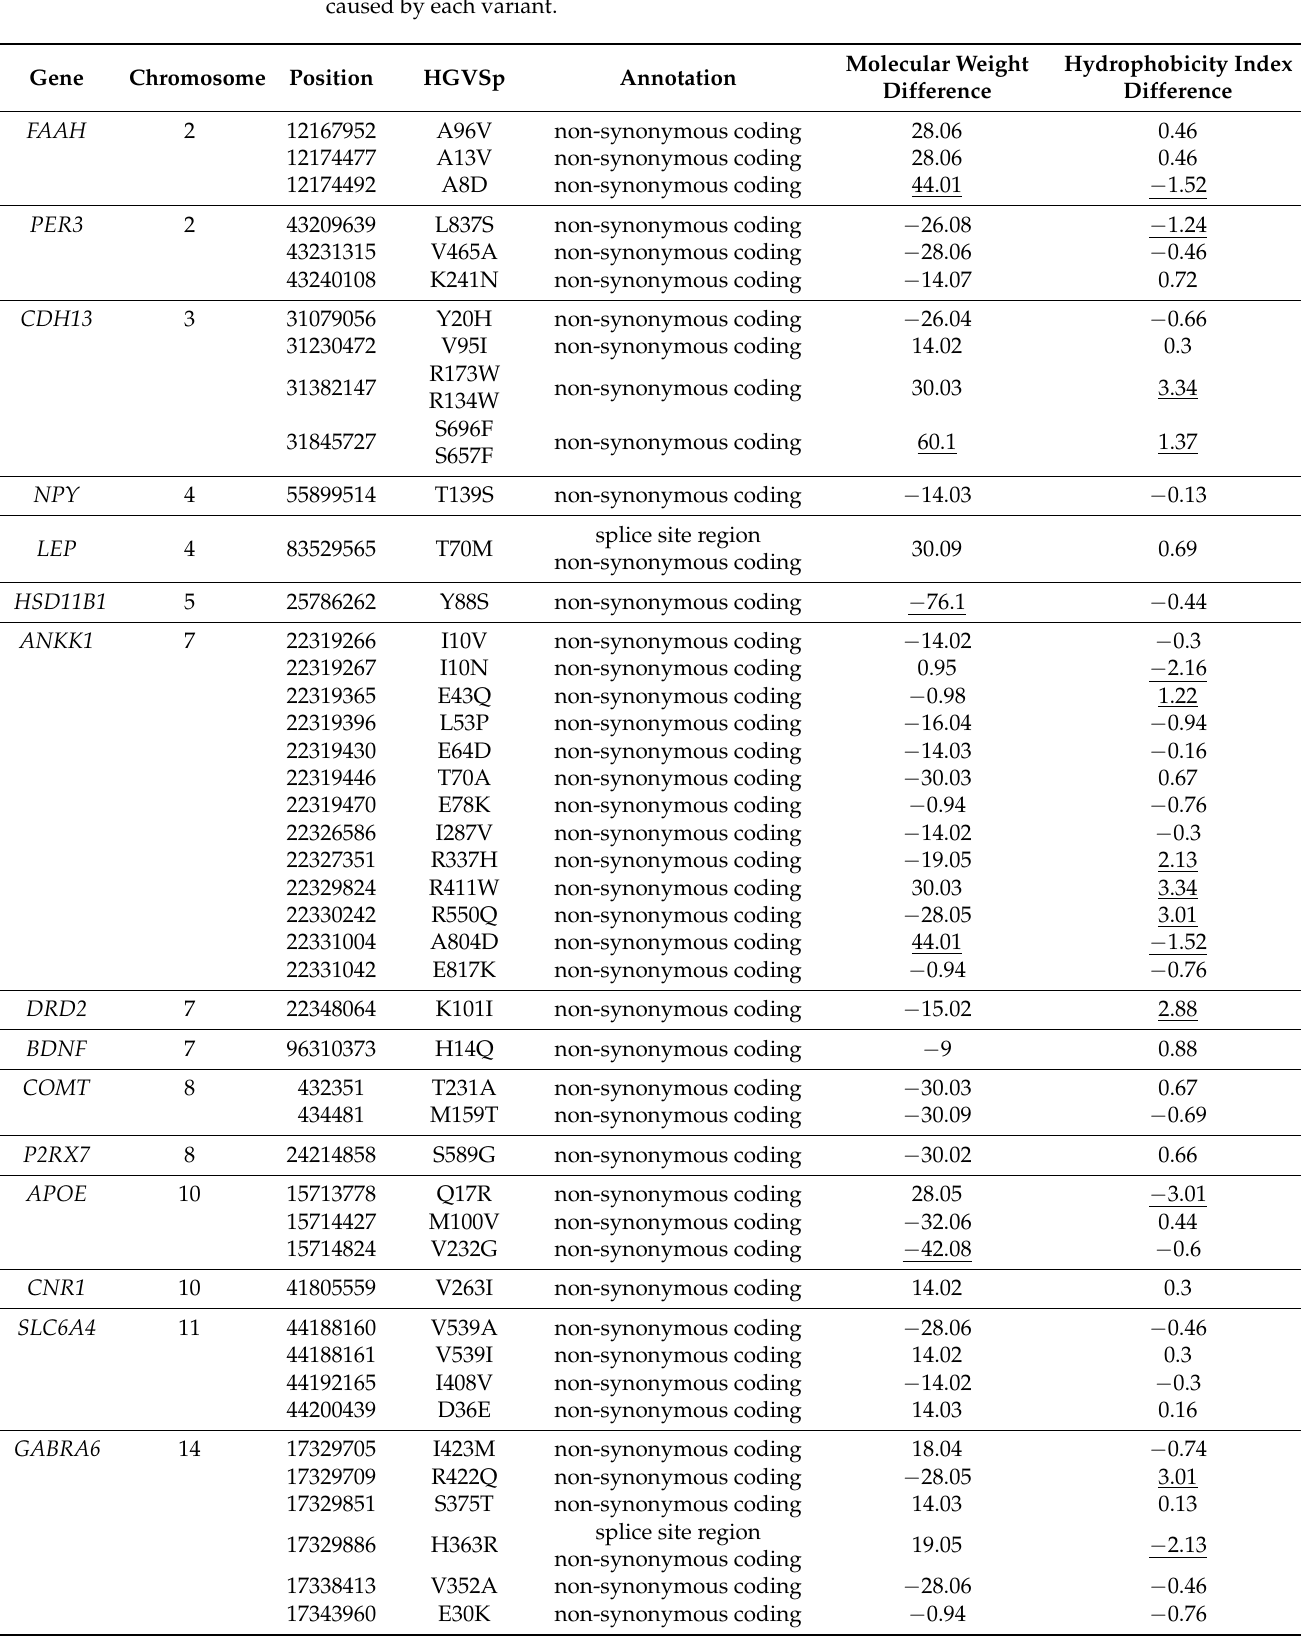
Table 3. Amino acid alterations and the differences in molecular weights and hydrophobicity levels caused by each